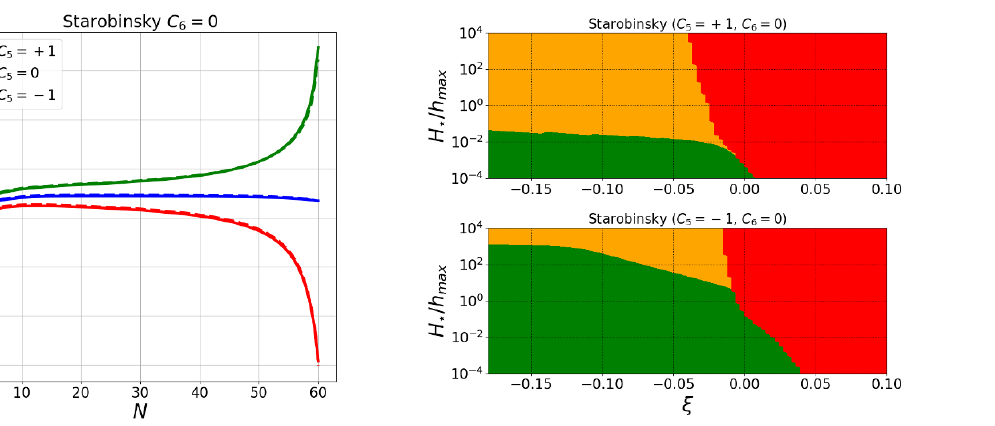
Figure 6. Impact of the dimension-(cid:12)ve operator in (2.6) on the fate of the Higgs for Starobinsky